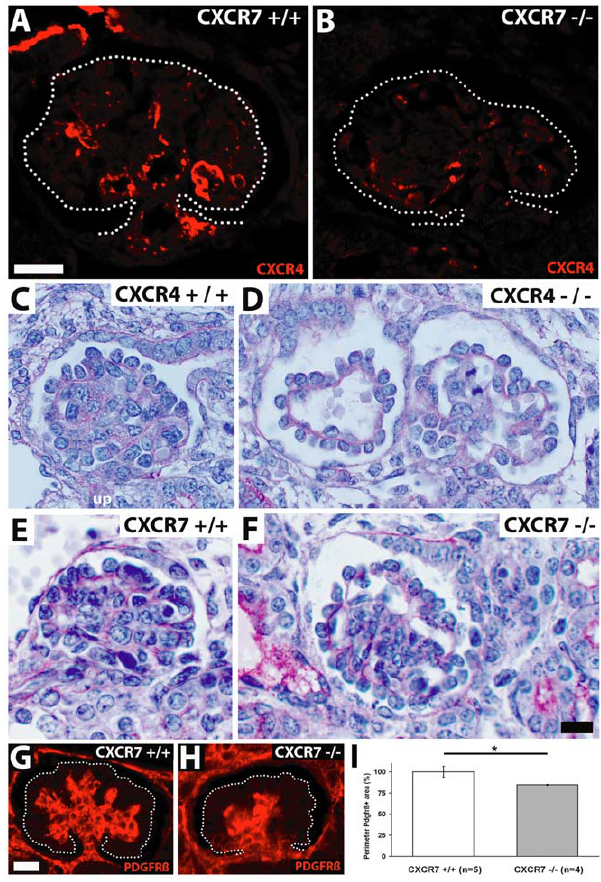
Figure 6. Comparison of glomerular tuft abnormalities in E16.5 CXCR7 and CXCR4 knockout mice. ( A , B ) Immunostainings of the CXCR4 protein in an E16.5 wildtype and a CXCR7 deficient littermate show decreased CXCR4-immunoreactivity in the glomerular tuft of the CXCR7 mutant (glomerular tufts are encircled). ( C – F ) PAS stained E16.5 kidney sections comparing glomeruli of wildtype (C, E) and mutant littermates (D,F). Note severe dilation of capillaries (right glomerulus in D) and a single ballooned capillary (left glomerulus in D) in the CXCR4 mutant. The glomerulus in the CXCR7 mutant (F) is similarly dilated as compared with the corresponding wildtype (E) but abnormalities within the capillary tuft are not as severe as in the CXCR4-mutant (D). ( G,H ) Micrographs of E16.5 glomeruli immunostained for the mesangium marker PDGFR b demonstrate mesangium agglutination in a CXCR7 knockout as compared with a wildtype littermate. Dotted lines encircle glomerular tufts. ( I ) The perimeter of the mesangial tree is reduced in CXCR7 knockout mice as compared with wildtype littermates (p , 0.05; Mann-Whitney U test). Data represent mean values 6 SEM as percentage of the wildtype group. Scale bars represent 10 m